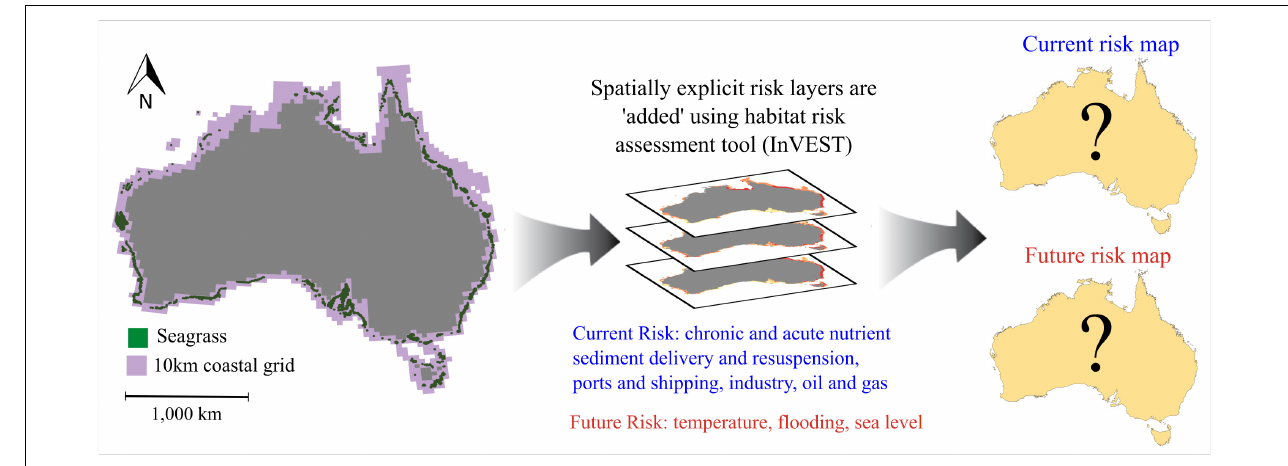
FIGURE 1 | Flow chart to demonstrate the approach for the cumulative risk assessment in this